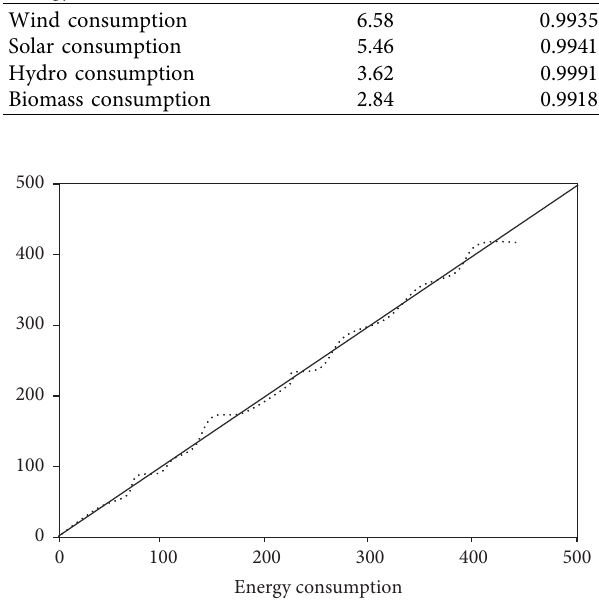
Figure 12: Green energy consumption within the